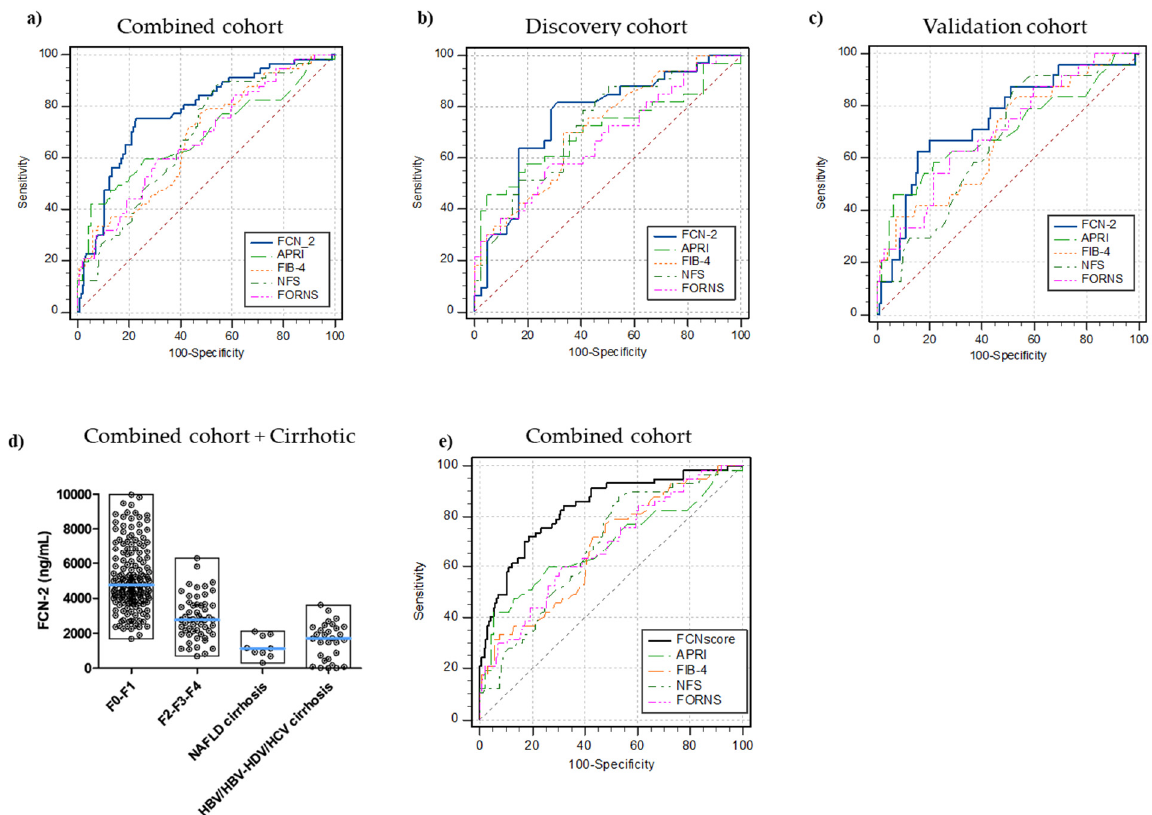
Figure 3. Receiver operating characteristic (ROC) curves for the diagnosis of significant fibrosis. FCN-2 vs. blood-based tests (APRI, FIB-4, NFS, FORNS) AUROCs in ( a ) combined cohort (n = 235, disease prevalence 24%), ( b ) discovery MO cohort (n = 76, disease prevalence 43%), ( c ) validation MO cohort (n = 159, disease prevalence 15%), ( d ) full picture for FCN-2 plasma levels in all samples included in the study, ( e ) FCNscore (FCN-2 levels, APRI, and HDL combined in a diagnostic model) vs. common blood-based tests (FIB-4, NFS, APRI, FORNS) AUROCs in the combined cohort. Significant fibrosis (F2, F3, and F4 stages).